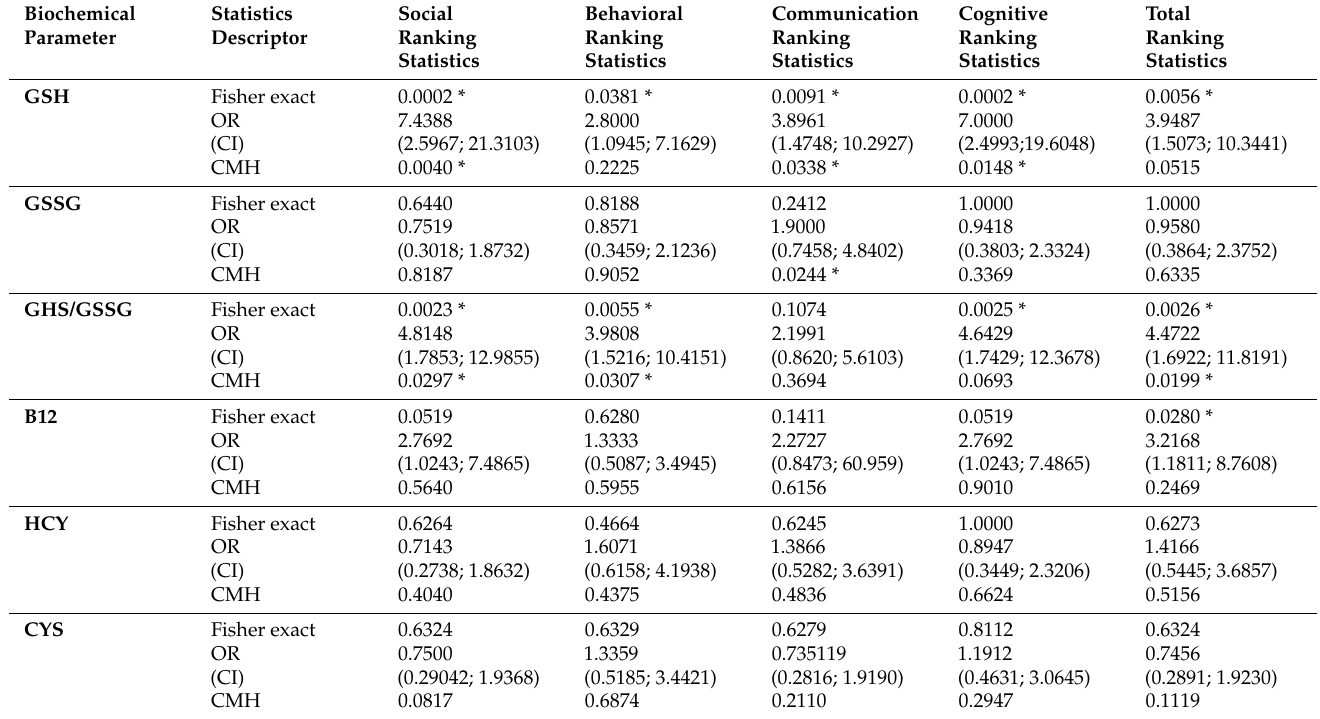
Table 3. Association between the biochemical parameters and the psychological or clinical data. Orig- inal rankings data were stratified by the respective medians to Hi (>median)) and Low (<= median) subgroups. For these transformed categorical data with a 2 × 2 design the Fisher exact test was applied, and the respective effects are described as odds ratios and 95% confidence intervals (CI). Time-related data was used as a third, blocking factor in the Cochran–Mantel–Haenszel tests (CMH). Statistical significance for p < 0.05 is indicated with the * asterisk